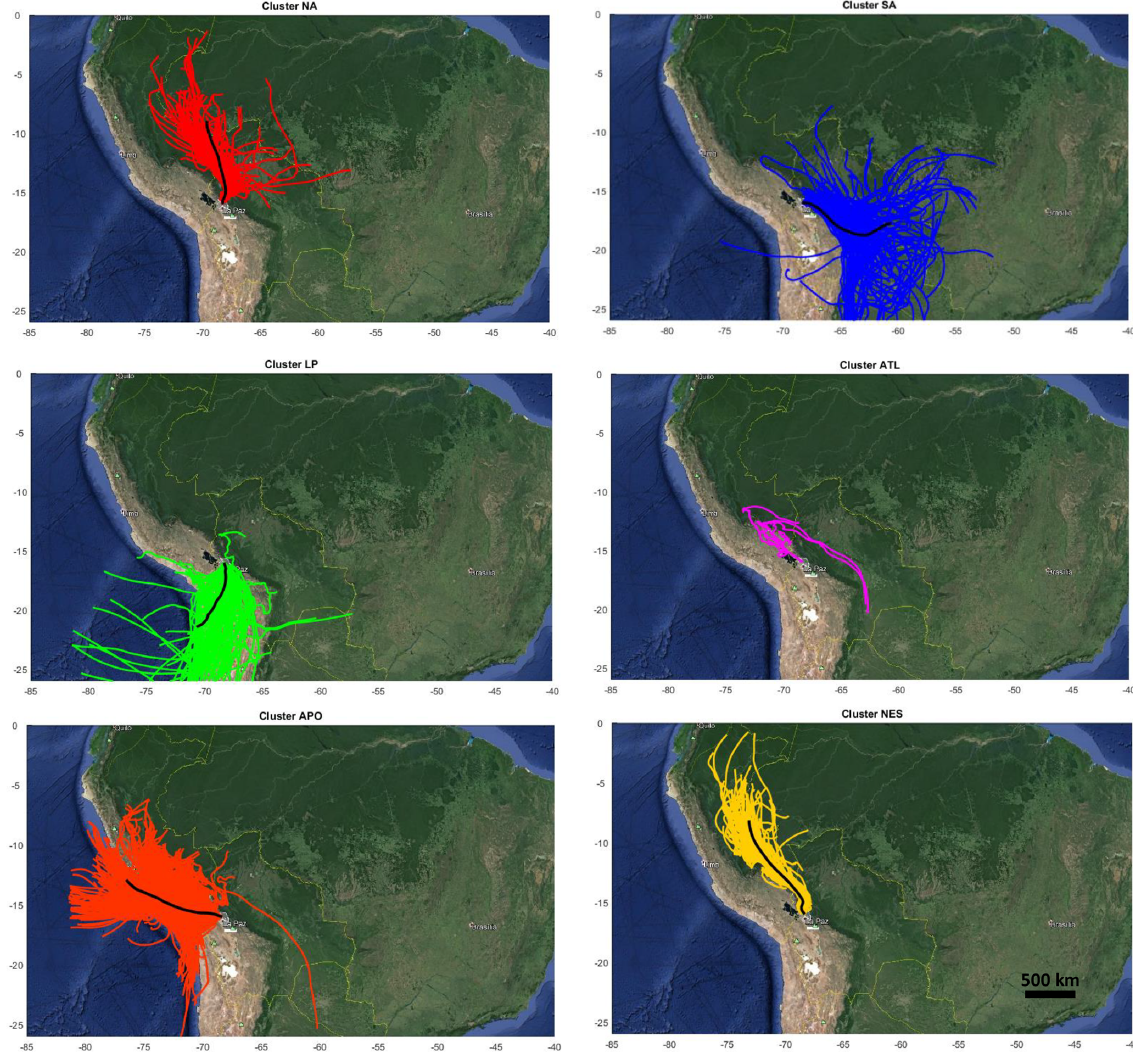
Figure A1. Selected 96h back-trajectories for the six clusters obtained with the Borge et al. (2007) method. The black line corresponds to the main back-trajectory. Background maps have been uploaded from © Google maps.